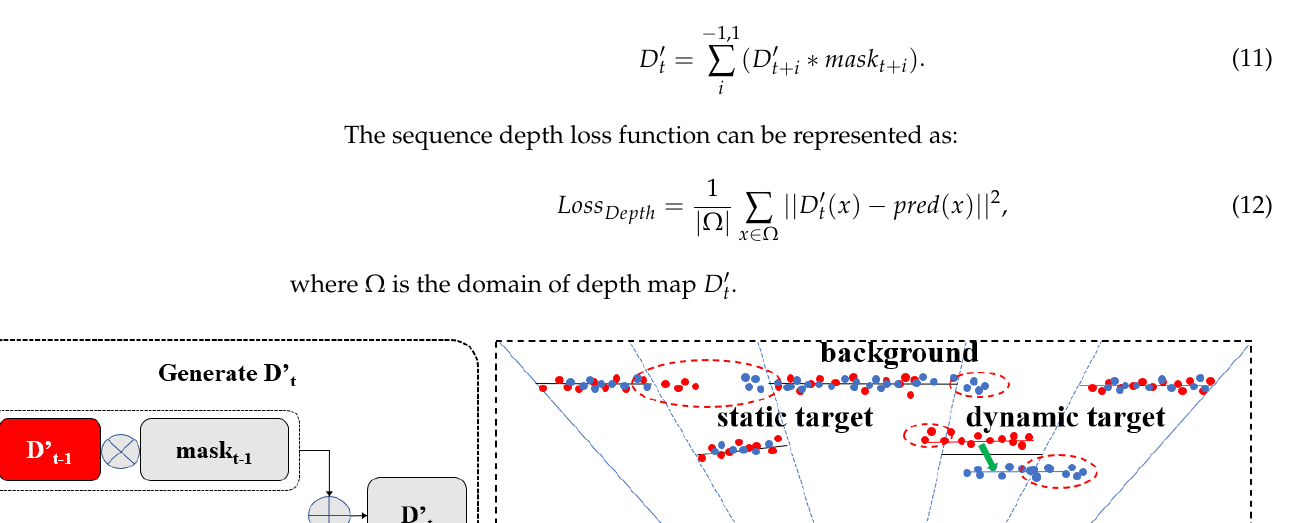
Figure 4. D (cid:48) t is generated by splicing high similarity points in participates in the loss function Loss Depth